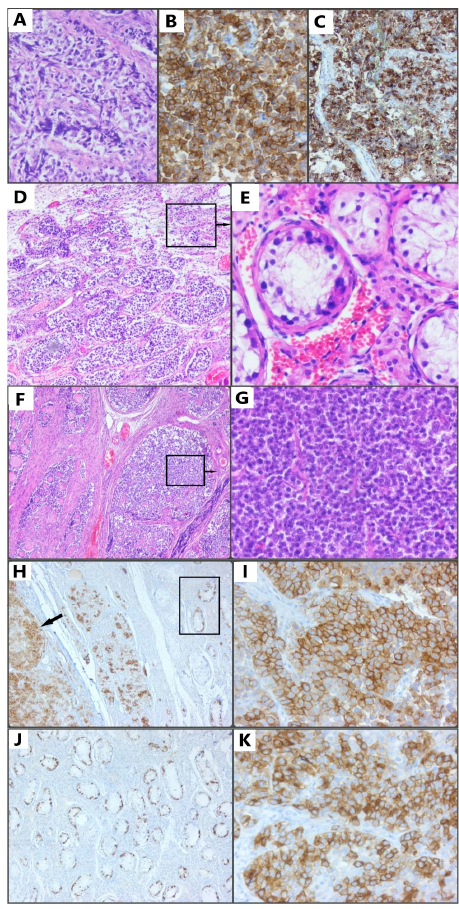
Figure 1. ( A ) Histologic features of dysgerminoma characterized by nests and nodules of uniform tumor cells, separated by fine connective tissue, containing inflammatory cells; the tumor cells are polygonal in shape, with clearly visible cell borders, an eosinophilic-to-clear cytoplasm, a round nucleus, and centrally located and prominent nucleoli; hematoxylin and eosin stain (HE, ob. 20 ×